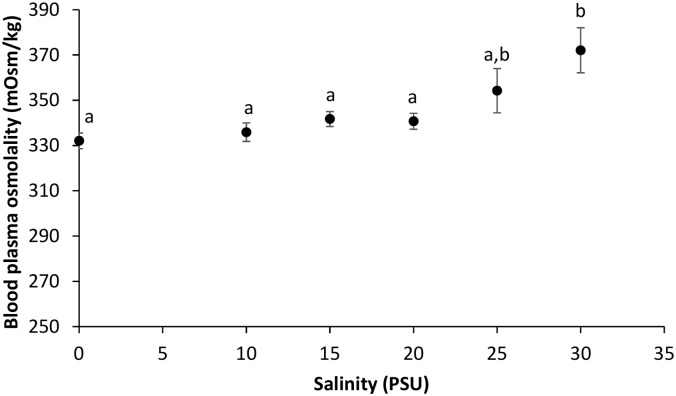
Relationship between ambient salinity and round goby plasma osmolality (mean ± SE).For all groups n = 10, except at 10 and 30 PSU where n = 9. Different letters denote significant differences in plasma osmolality between treatment groups.